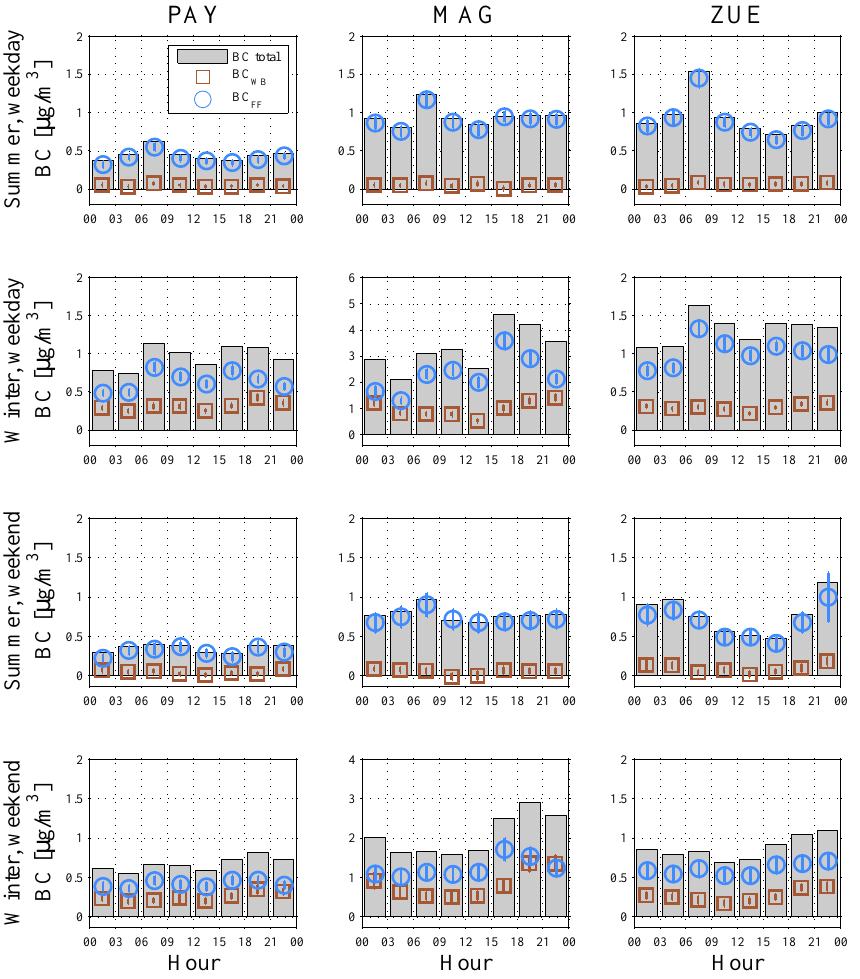
Fig. 4. Diurnal cycles of BC FF , BC WB and total BC concentrations at PAY (column 1), MAG (column 2) and ZUE (column 3). The widths of the uncertainty bands for the estimated mean values are indicated as vertical lines in the symbols. At every site the data were filtered and analyzed for different conditions: weekdays in summer, weekdays in winter, weekend in summer and weekend in winter which are presented in row 1 to 4,